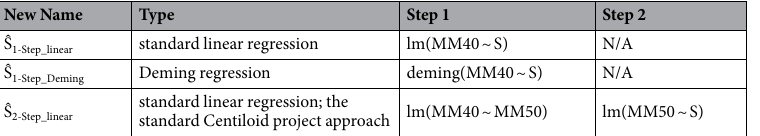
Table 2. Description of the regression variations compared in this work. Regression steps are specified in the R programming language, which uses a method (response ~ predictor) format.